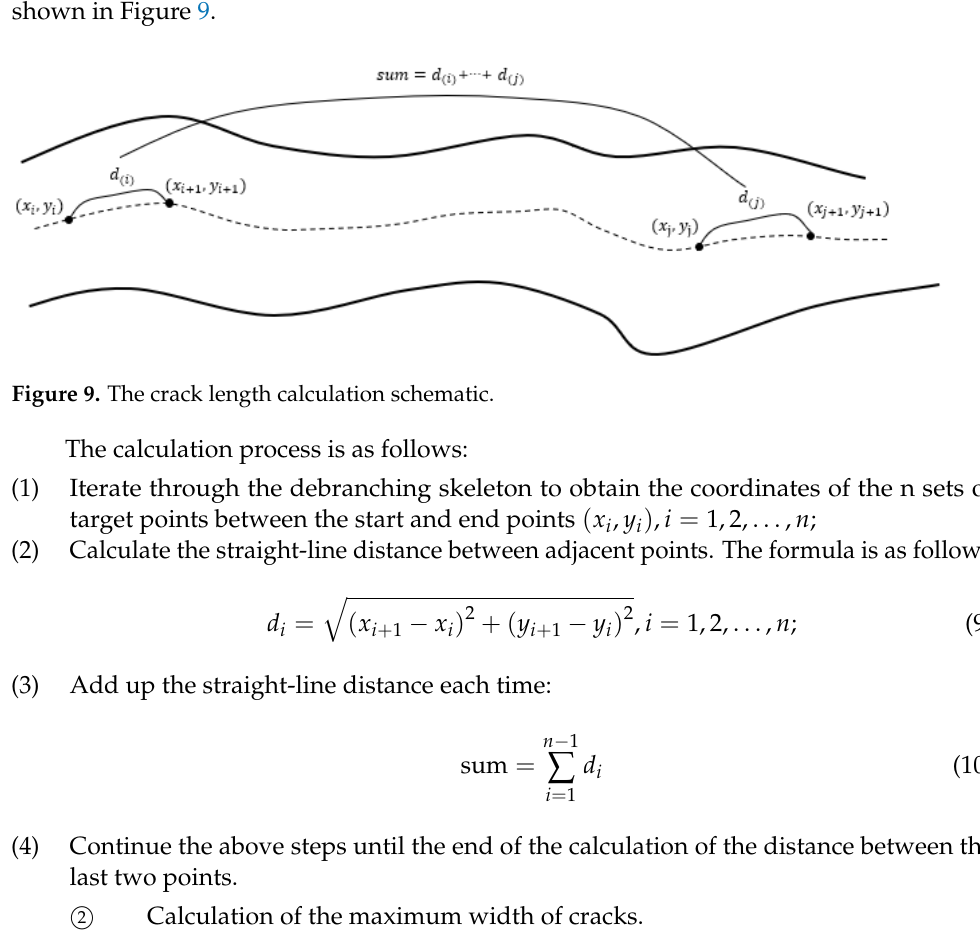
Figure 9. The crack length calculation schematic. The calculation process is as follows: (1) Iterate through the debranching skeleton to obtain the coordinates of the n sets of target points between the start and end points (𝑥 (cid:3036) , 𝑦 (cid:3036) ), 𝑖 = 1,2, … , 𝑛 ; (2)